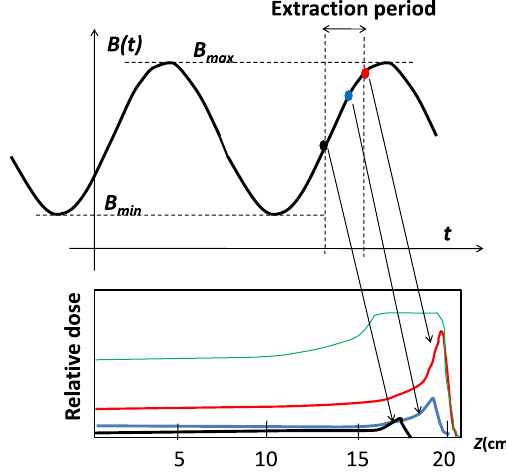
FIG. 1. Energy sweep extraction in one acceleration cycle and the integrated dose along the path, where B ð t Þ is the magnetic flux density of the guiding magnet.